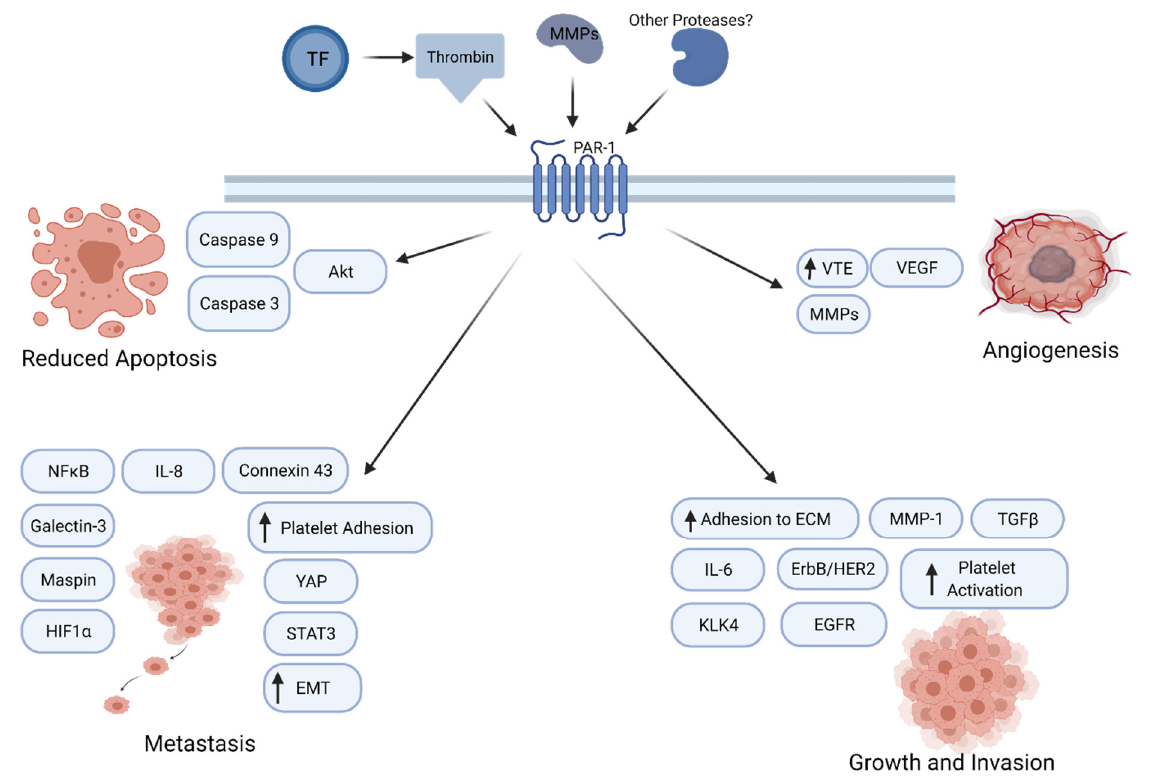
Figure 1. PAR1 signaling in cancer progression. PAR1 promotes tumor growth, angiogenesis, invasion, and metastasis through multiple molecular mechanisms.